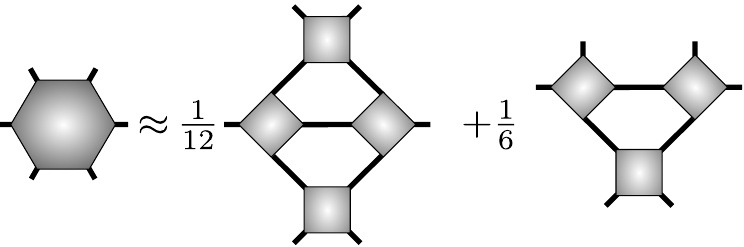
Figure 10: Two-loop approximation for the six-point